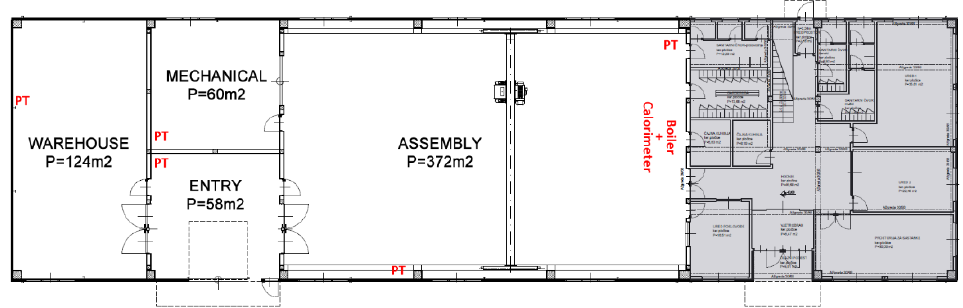
Figure 7. Internal layout of test building (“PT” marks the location of the temperature sensors).